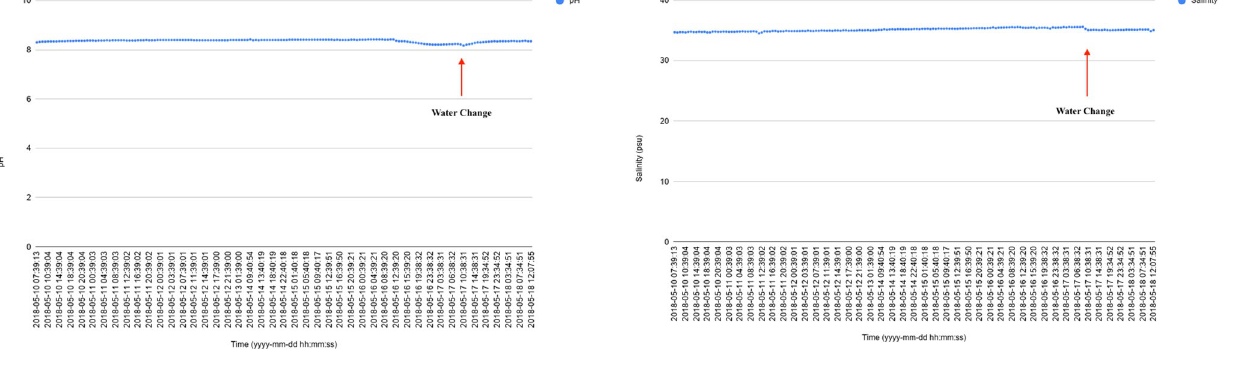
Fig. 13 pH data from multi-sensor node while monitoring the Kob experiment